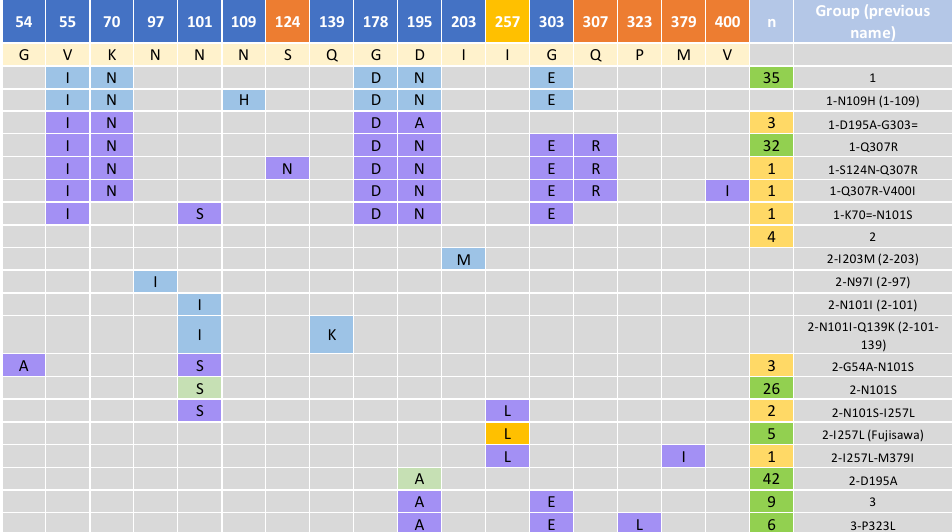
Figure 3. Adapted figure from Forde et al. showing discriminatory amino acid positions within the SpaA protein’s hypervariable region of E. rhusiopathiae . Variant positions and amino acids are relative to the Fujisawa reference sequence and are shown in the first and second rows, respectively (except position 257). Positions in orange represent novel positions observed in this study, while position 257 represents a variant position only previously observed as a variant in the Fujisawa reference genome (L). Previously reported groups and variant positions by Forde et al. are shown in blue, the variants 2-D195A and 2-N101S previously identified by Uchiyama et al., 2016 [42] and Janßen et al., 2015 in light green. Novel groups and their variants are shown in purple. The number of isolates from this study are shown for each group, in green for groups with >5 isolates and yellow for groups with <5 isolates.